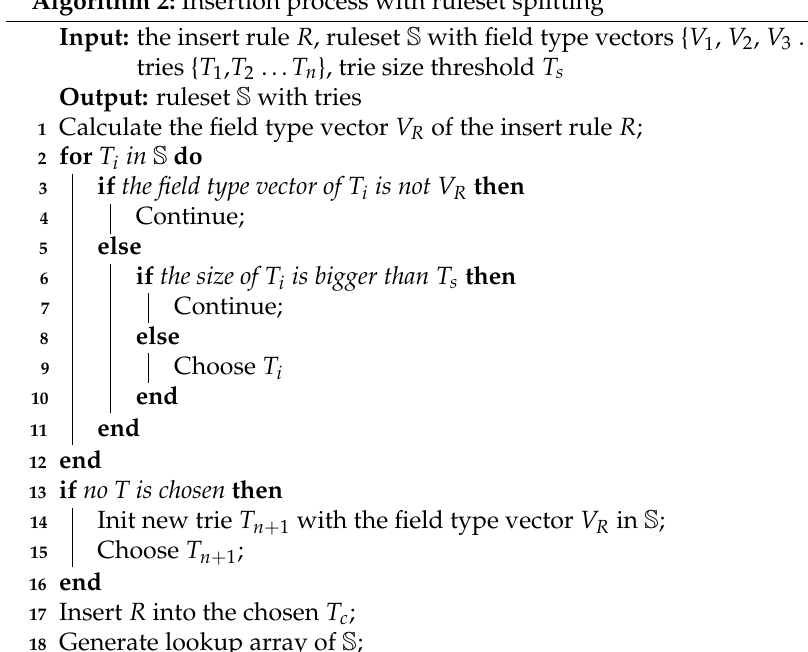
Algorithm 2: Insertion process with ruleset